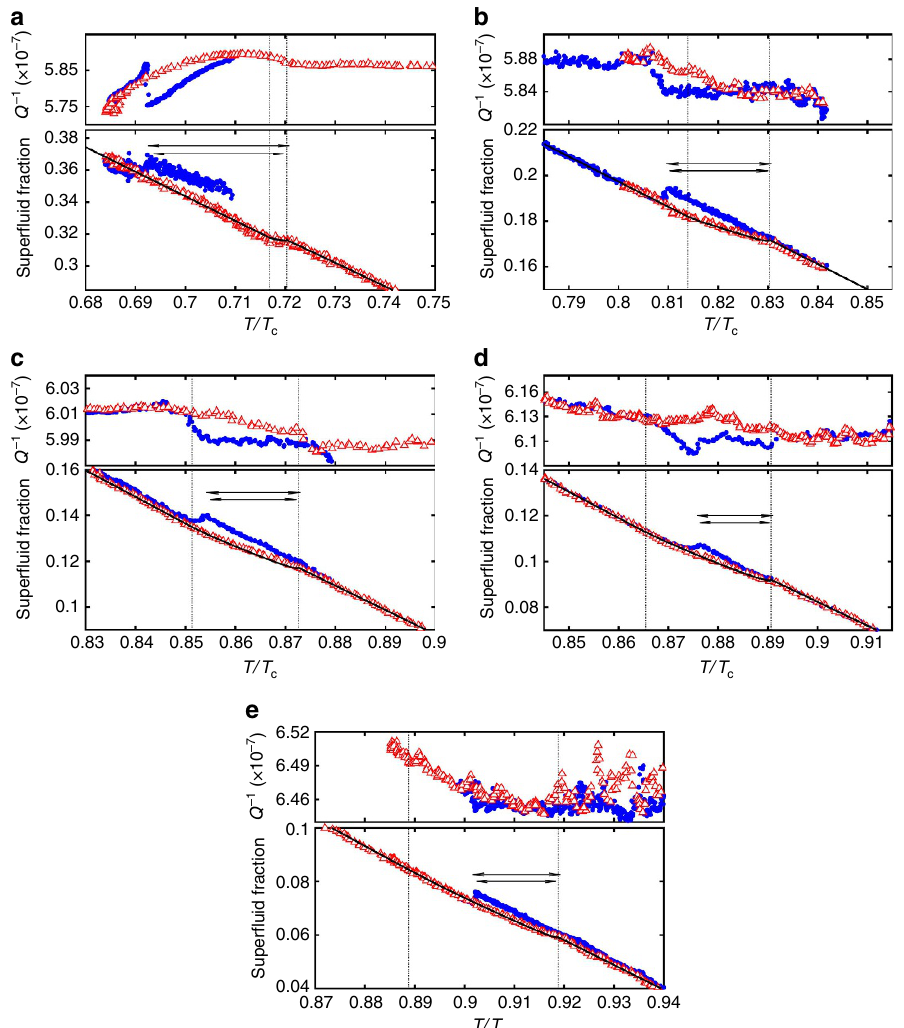
Figure 3 | Superfluid fraction and dissipation at the A-B transition. Measured superfluid fraction and dissipation ( Q (cid:3) 1 ) near the A–B transition at ( a ) 0.1bar, ( b ) 1.4bar, ( c ) 2.5bar, ( d ) 3.6bar and ( e ) 5.6bar. The dotted vertical lines mark the onset T lower B–A transition on warming (open red triangles). This gradual transition is associated with the pressure-induced cavity height distribution; solid black lines show fits to the data assuming the transition at constant reduced thickness D / x D ( T AB ) see Supplementary Note 1 for details. On cooling (filled blue circles) the B phase nucleates abruptly from the supercooled A phase. At 2.5–5.6bar, the supercooling is smaller than the width of the warming transition, and the jump corresponds to a transition from pure A phase into spatially separated A/B phase coexistence. The dissipation increases across the A–B transition, particularly at low pressures. Horizontal arrows designate the range of the mean supercooling, d T = T c ; measured at that pressure. Values for various relevant quantities are listed in Table